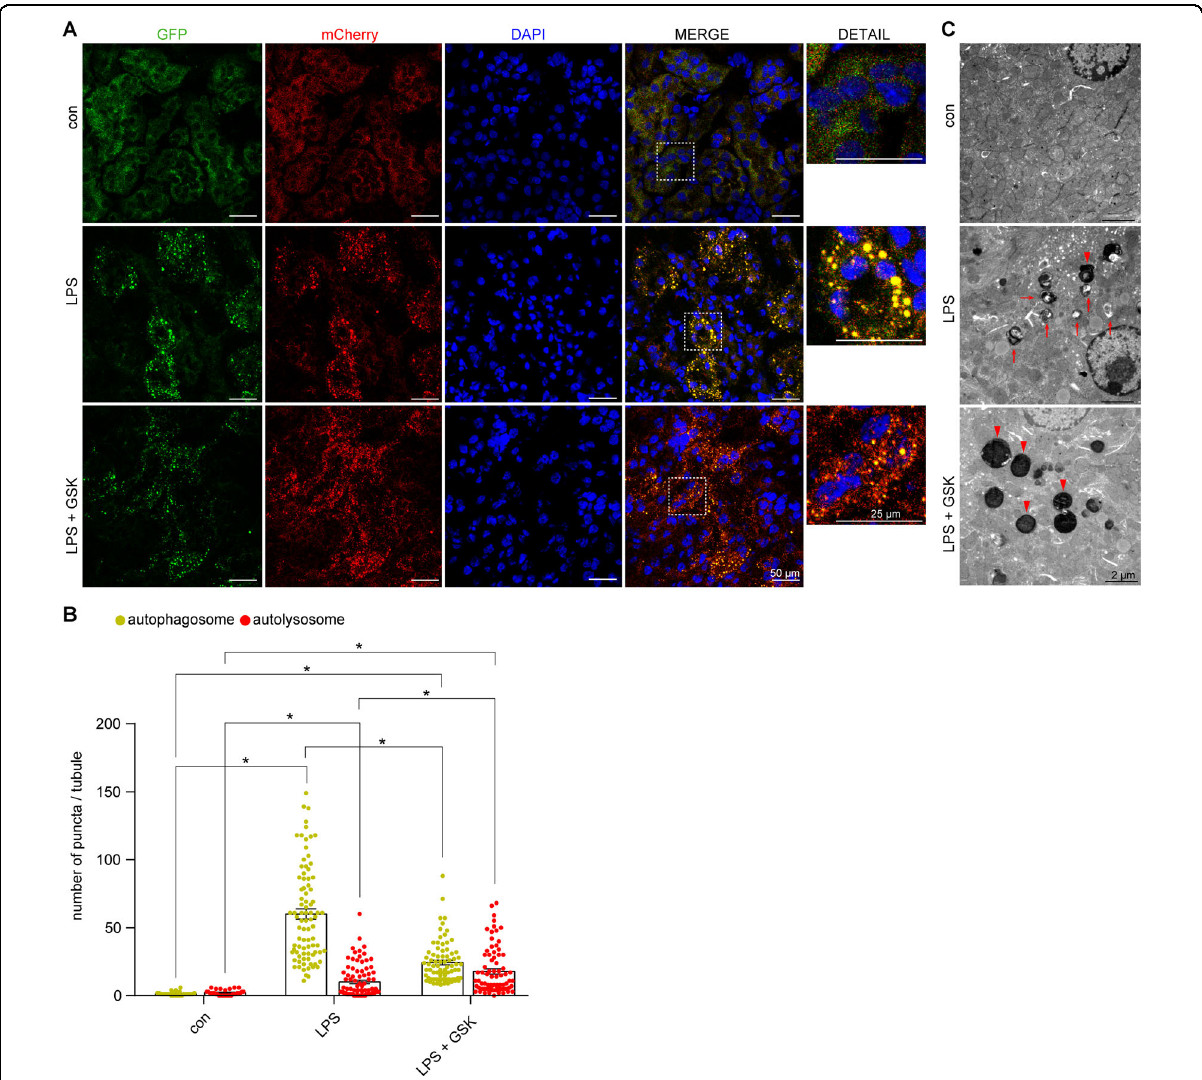
Fig. 2 RIP3 was activated to suppress autophagic fl ux in septic AKI mice. A Confocal laser scanning microscopy images of kidney tissues from renal tubular cell-speci fi c mCherry-GFP-LC3 reporter mice treated as indicated. Scale bar = 50 μ m for the left four lanes, 25 μ m for the detailed images. B Quantitative analysis showed few autophagosomes (yellow puncta) and autolysosomes (red-only puncta) were detected in the renal tubular cells of the control group. The number of autophagosomes were largely increased, with a slight increase in the number of autolysosomes, in the LPS group. GSK induced the formation of autolysosomes and decreased the LPS-induced accumulation of autophagosomes ( n = 3 – 4, 32 – 86 tubules from each group). C TEM showed that few autophagic vacuoles were detected in the renal tubular cells of the control mice. A lot of initial autophagic vacuoles (arrows) but few late autophagic vehicles (arrowheads) were detected in the renal tubular cells of LPS-induced mice. GSK induced the formation of late autophagic vehicles and decreased the number of initial autophagic vacuoles. Scale bar = 2 μ m. * P <